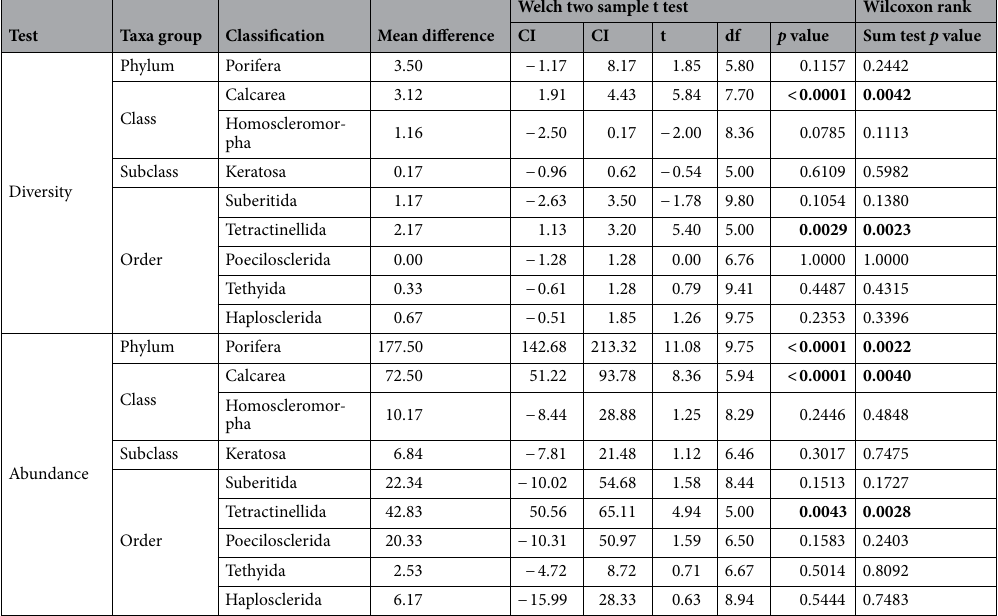
Table 1. Parametric (Welch Two Sample t-test) and nonparametric (Wilcoxon Rank Sum Test) paired t test results comparing cumulative observed diversity and abundance from different sponge groups from reef and mesocosm ARMS. Significant values are in